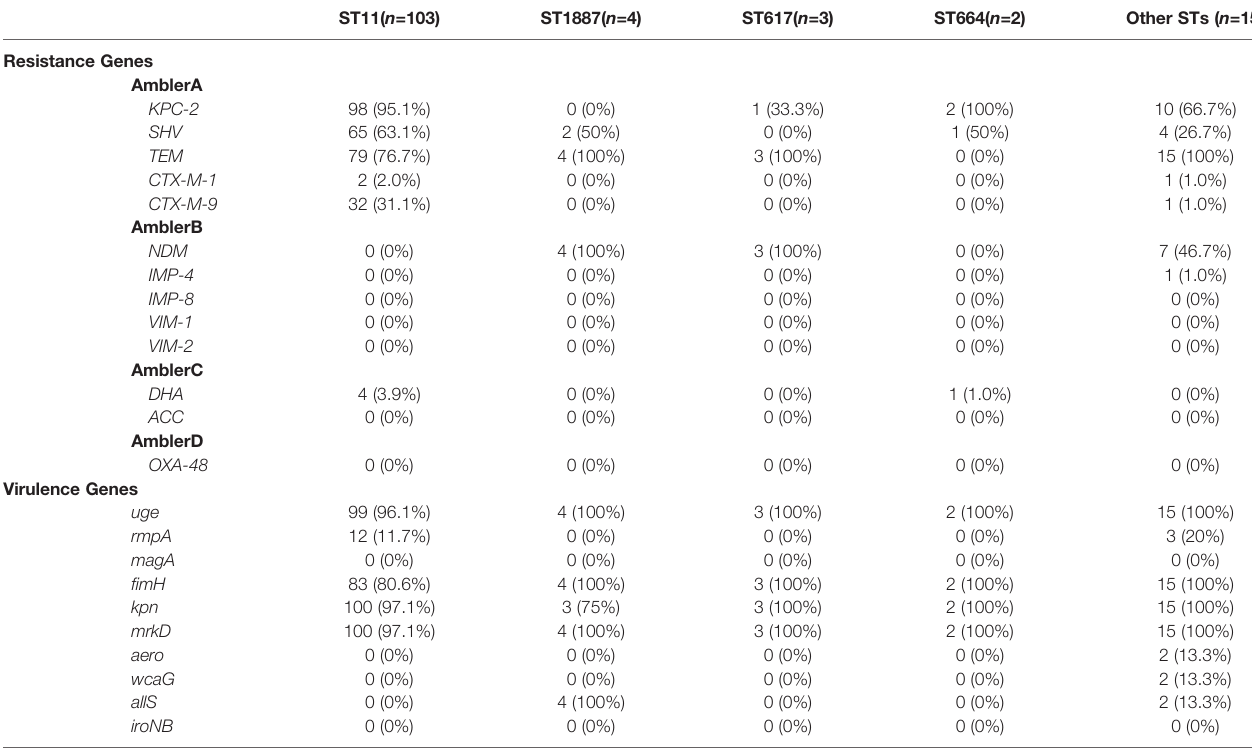
TABLE 1 | Resistance and virulence genes in different